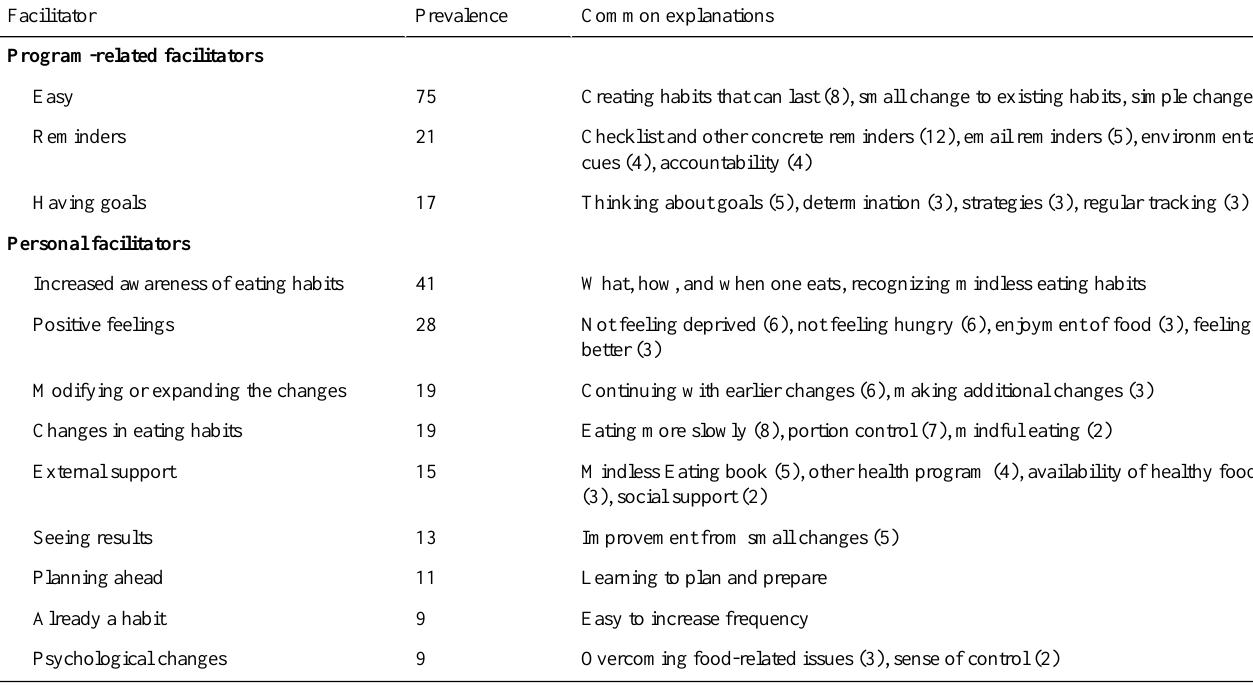
Table 6. Common facilitators of changes based on